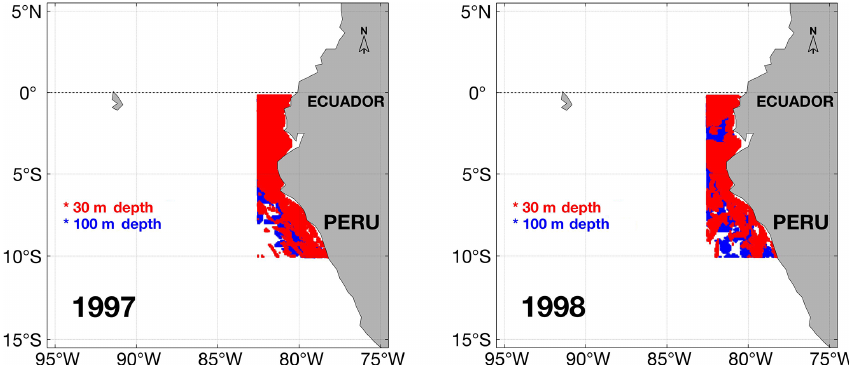
Figure 1. Representation of particles “seeded” (initial positions) off Peru and Ecuador at 30m depth (red dots) and 100m depth (blue dots) for upwelling rates exceeding 1 . 9 × 10 − 5 ms − 1 (50mmonth − 1 ) in the region bounded by 10 ◦ S, 82.5 ◦ W, and the Equator, in this particular case for 1997 and 1998. Particles were released at the end of each month in December–January, for each year, over the period 1988 to 2007. Consider that the initial particles here represented as blue and red dots are overlapping each other, although 30m released depth is in the front, while 100m released depth is in the background,